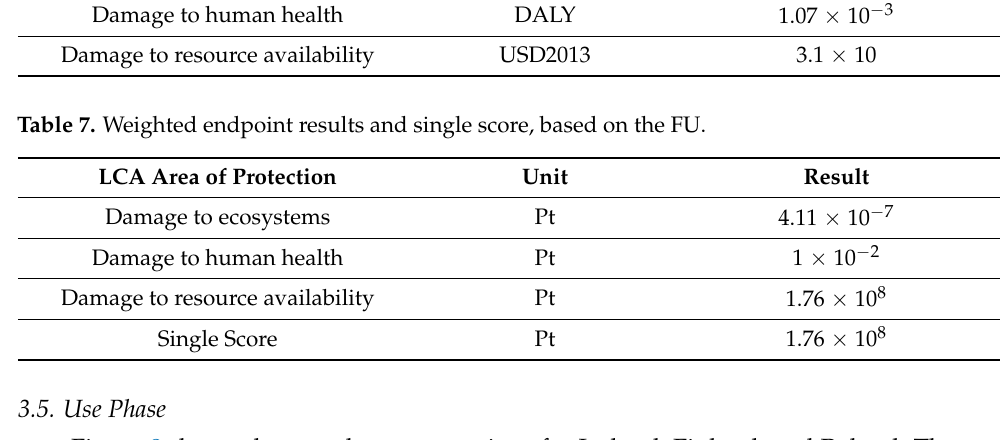
Table 7. Weighted endpoint results and single score, based on the FU.